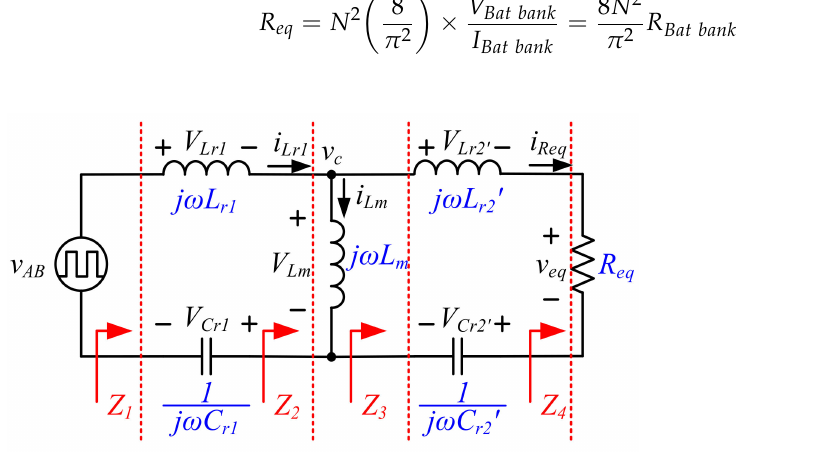
Figure 2. Equivalent circuit diagram of the proposed bidirectional CL 3 C resonant converter in the charging